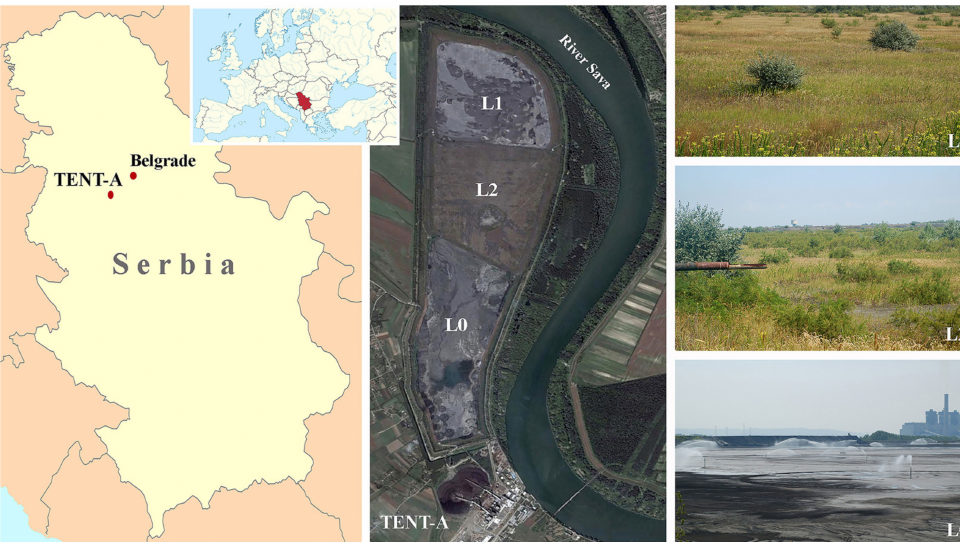
Figure 1. Location map showing the fly ash disposal site at the thermal power plant ‘Nikola Tesla A’ (TENT—A), Obrenovac (Serbia); L0—active lagoon, L1 and L2—passive lagoons (study sites).